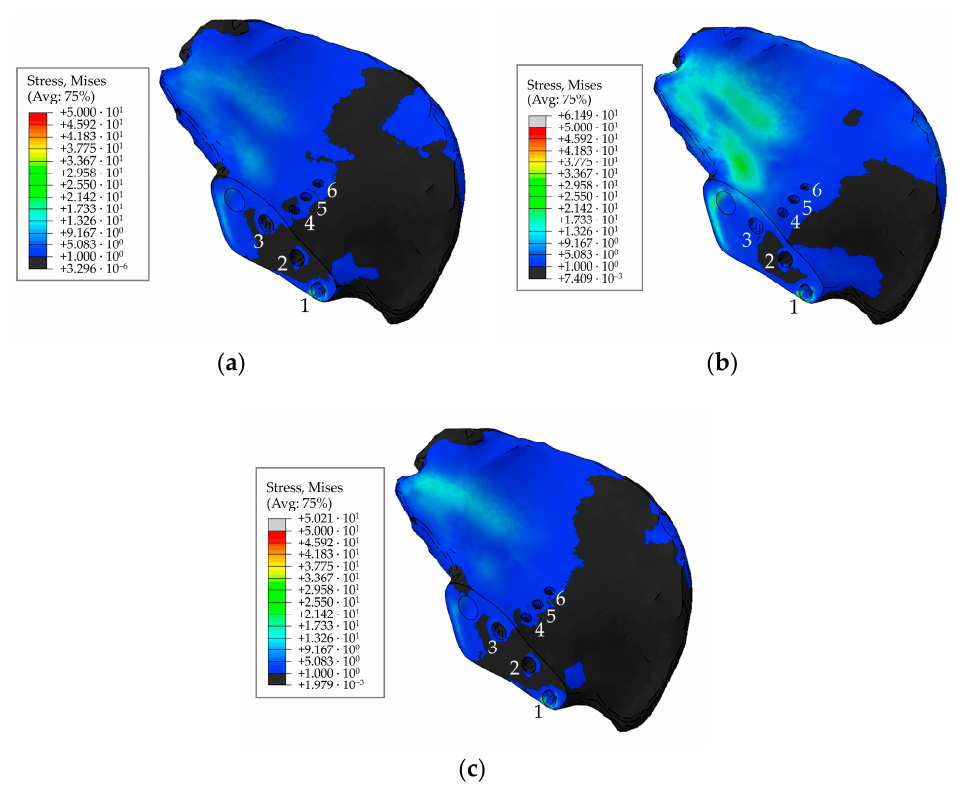
Figure 28. Stress distribution for a pretension force of 50 N and the hole numbering convention in the right pelvic bone: ( a ) in 63% phase; ( b ) for ascending stairs; ( c ) for descending stairs, MPa.